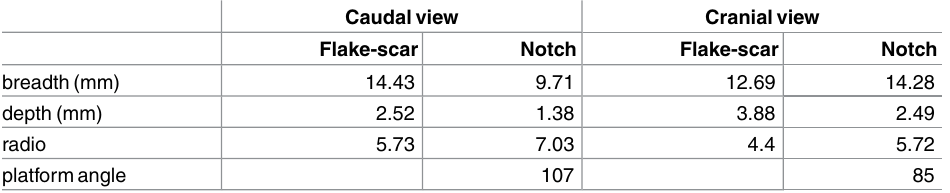
Table 3. Measurements on notchshapesand platformanglesfrom the radiusof Equusneogeus dated12,170 ± 45 14 C yrs B.P.